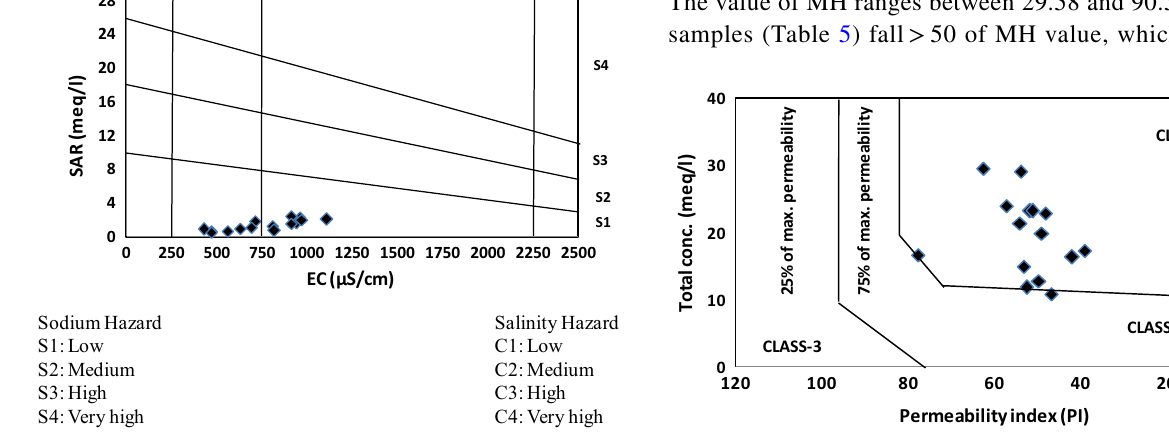
Fig. 7 Rating of groundwater samples in relation to salinity hazard and alkali hazard (after US Salinity Laboratory diagram 1954)